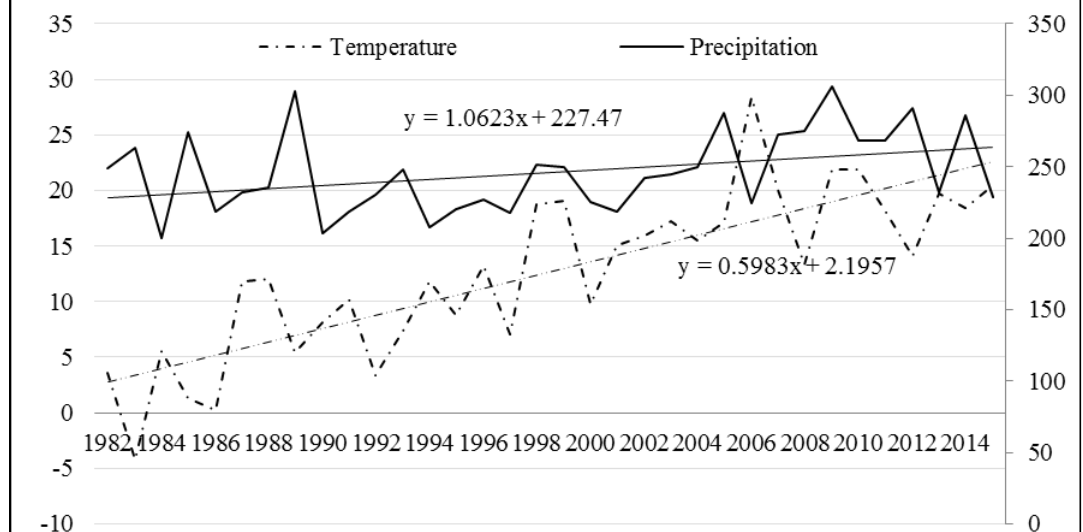
Fig.5 Changes of the Average Temperature and Precipitation in the Study Area from 1982 to